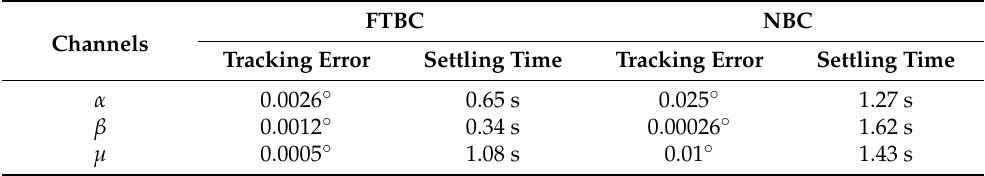
Table 4. Comparison of the attitude angle tracking performance of FTBC and NBC.